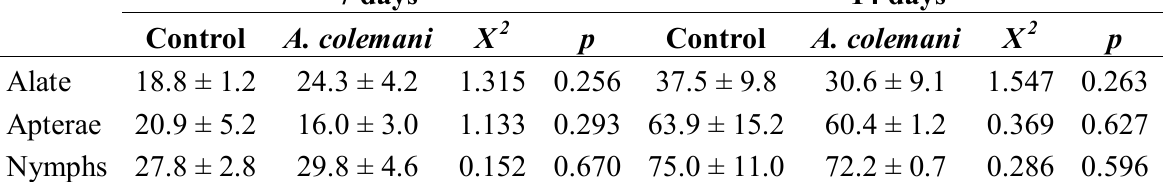
Table 5. Mean ± S.E. percentage of test plants occupied by one or more alate, apterae or nymphs (occupancy rate) in CABYV assays at 7 and 14 days in cages with and without (control) A. colemani followed by statistics according to a Chi-square 2x2 table test goodness of fit test ( p